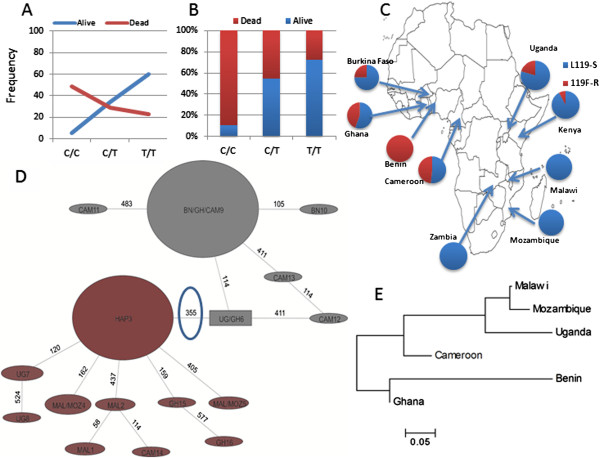
L119F association with DDT resistance and GSTe2 variability across Africa. (A) Evidence of the strong correlation between L119F genotypes and DDT resistance in Gounougou (Cameroon) (25 resistant and 25 susceptible). (B) Differential distribution of L119F genotypes between DDT-resistant and DDT-susceptible mosquitoes. (C) The geographical distribution of L119F across Africa correlates with the DDT resistance distribution. (D)GSTe2 haplotype network (TCS) (coding regions only) across Africa, with resistant (grey) and susceptible (maroon) clades defined by L119F. Each haplotype is represented by a circular or rectangular shape and the size proportional to its frequency in the sample while mutational steps are represented by line numbers. (E) Genetic distances between six African populations based on GSTe2 sequences (Nst estimates). DDT, dichlorodiphenyltrichloroethane.